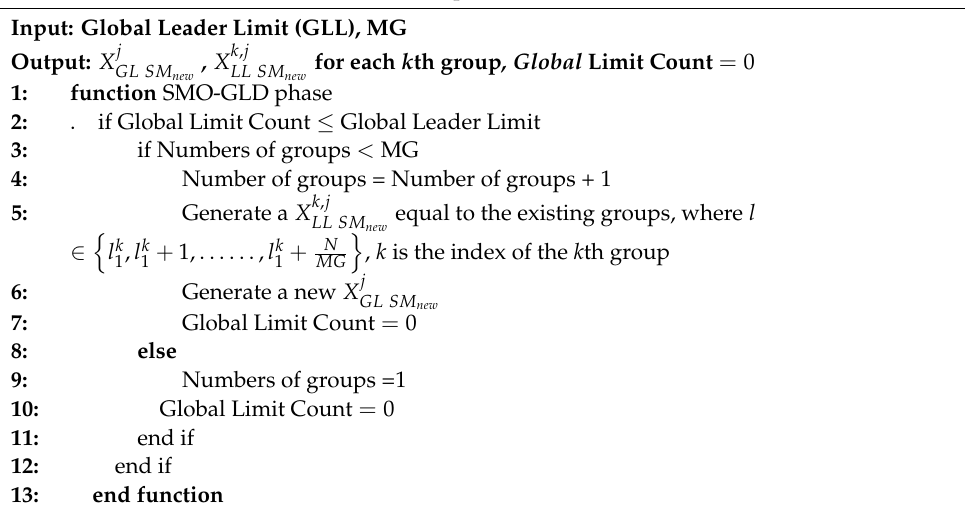
Algorithm 4: Global Leader Decision (GLD)